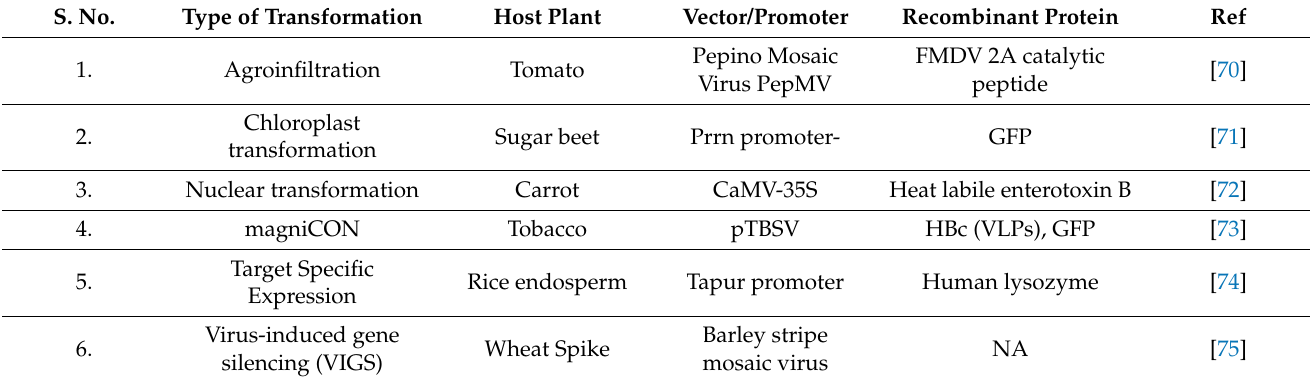
Table 4. Tabulation of distinct types of transformation in various host, their vector and the recombi- nant protein